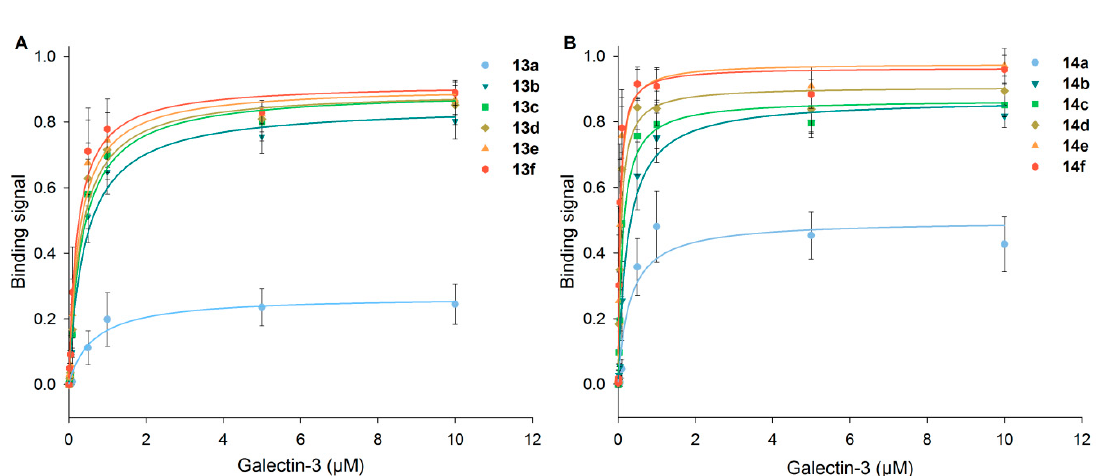
Figure 4. Binding of human Gal-3 to neo-glycoproteins presenting different numbers of glycans. In an ELISA-type assay, Gal-3 at different concentrations was incubated on immobilized 6-biotin LacNAc-LacNAc- ( 13a – f ) ( A ) and 6-biotin LacdiNAc-LacNAc-conjugated ( 14a – f ) BSA ( B ) (5 pmol per well). Binding signals were plotted against galectin concentration and